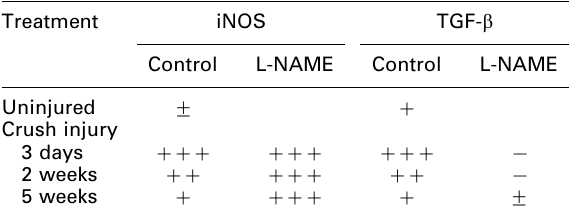
Table 1. Expression of iNOS and TGF- b in the healing tendon of standard and L-NAME-treated animals after crush injury of the rat digital flexor tendon and synovium Treatment iNOS